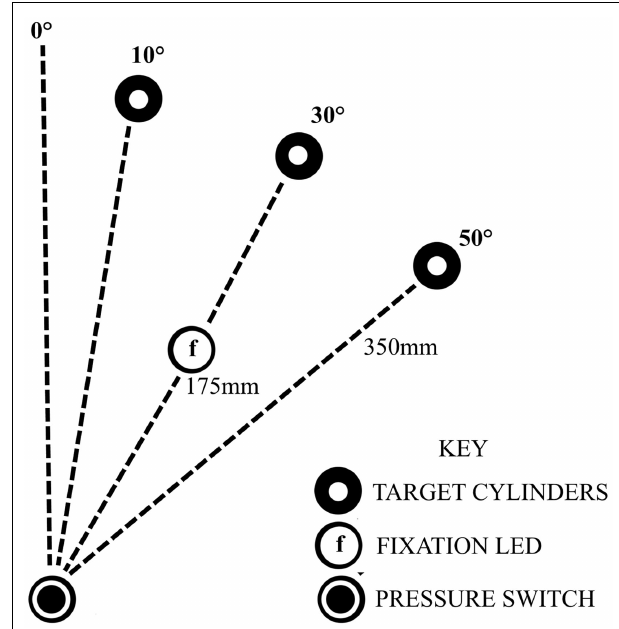
FIGURE 1 | Experimental set-up, showing the configuration for a participant with a ride sided lesion, reaching with affected left arm to the opposing side